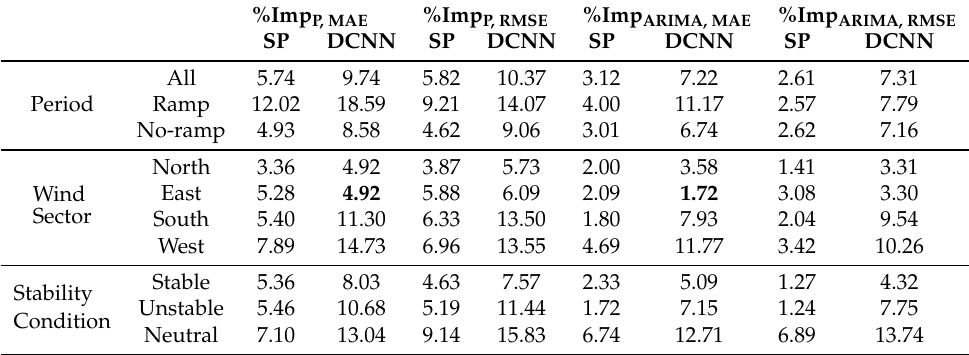
Table 3. Improvement over persistence (%Imp P ) and ARIMA (%Imp ARIMA ) expressed in terms of the MAE and RMSE. Forecasts performances are broken down by wind sector, atmospheric stability condition and period. Instances where the performance of DCNN < SP are shown in